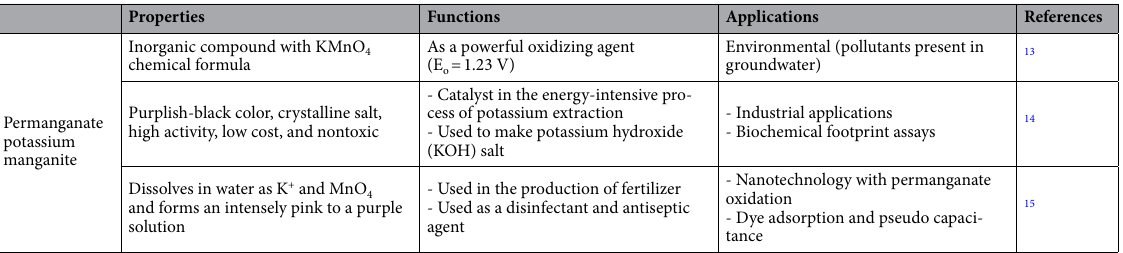
Table 3. Some physical properties, functions, and applications of potassium